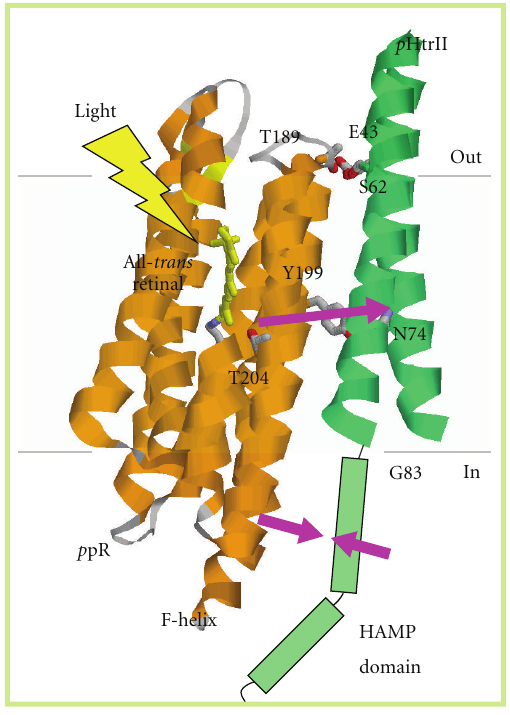
Figure 8: Schematic drawing of the signal relay from the receptor ( p pR) to the transducer ( p HtrII) in the archaeal photosensory transduction. In the X-ray crystallographic structure of the complex between p pR (left) and p HtrII (right) (PDB code, 1H2S) [29], the structure of p HtrII at position 83–114 was not determined, suggesting multiple conformations of the region. The association between p pR and p HtrII originates mostly from van der Waals contacts in the transmembrane region, whereas Tyr199 and Thr189 of p pR form hydrogen bonds with Asn74 and Glu43/Ser62 of p HtrII,